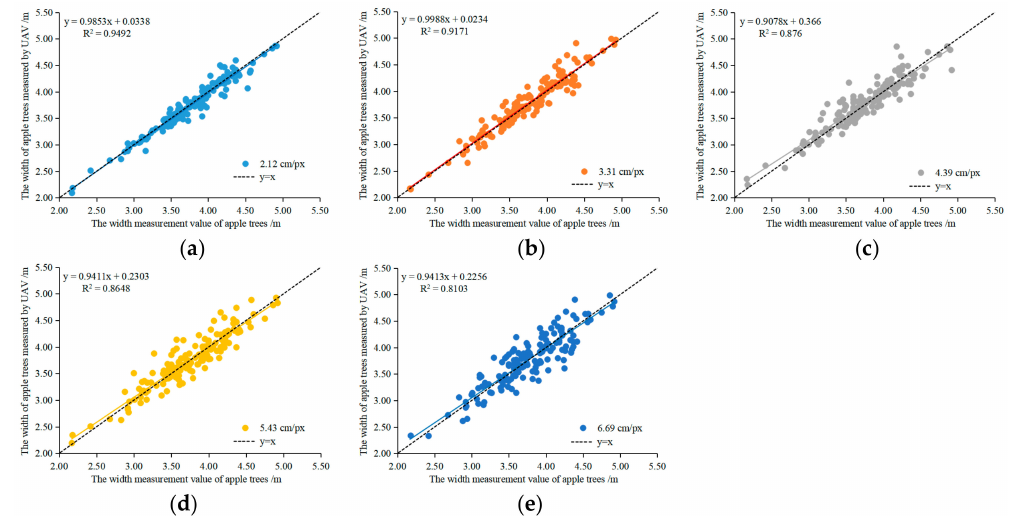
Figure 9. Canopy width values measured manually and estimated by UAV. ( a ) GSD = 2.12 cm / px; ( b )